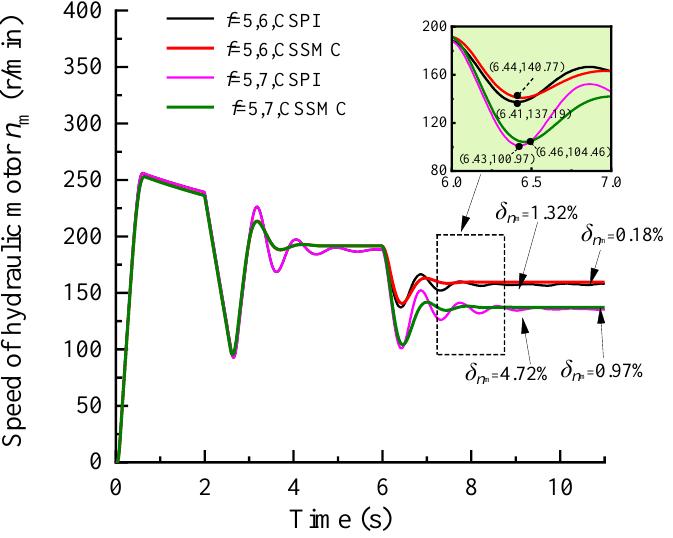
Figure 10. Variation curve of the hydraulic motor speed based on the CSPI and CSSMC.